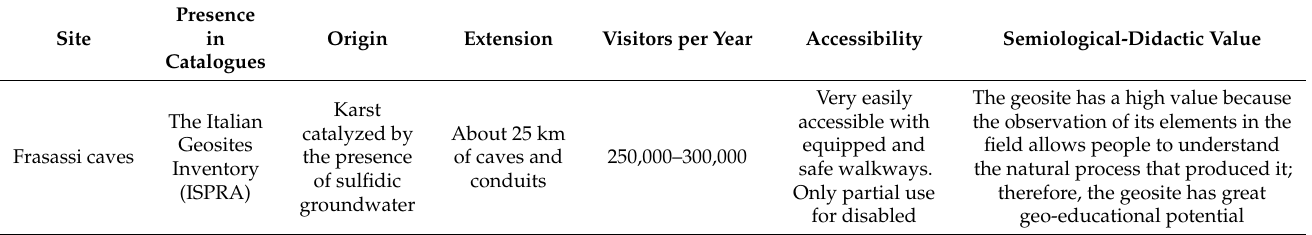
Table 1. A characterization of the geosite of Frasassi